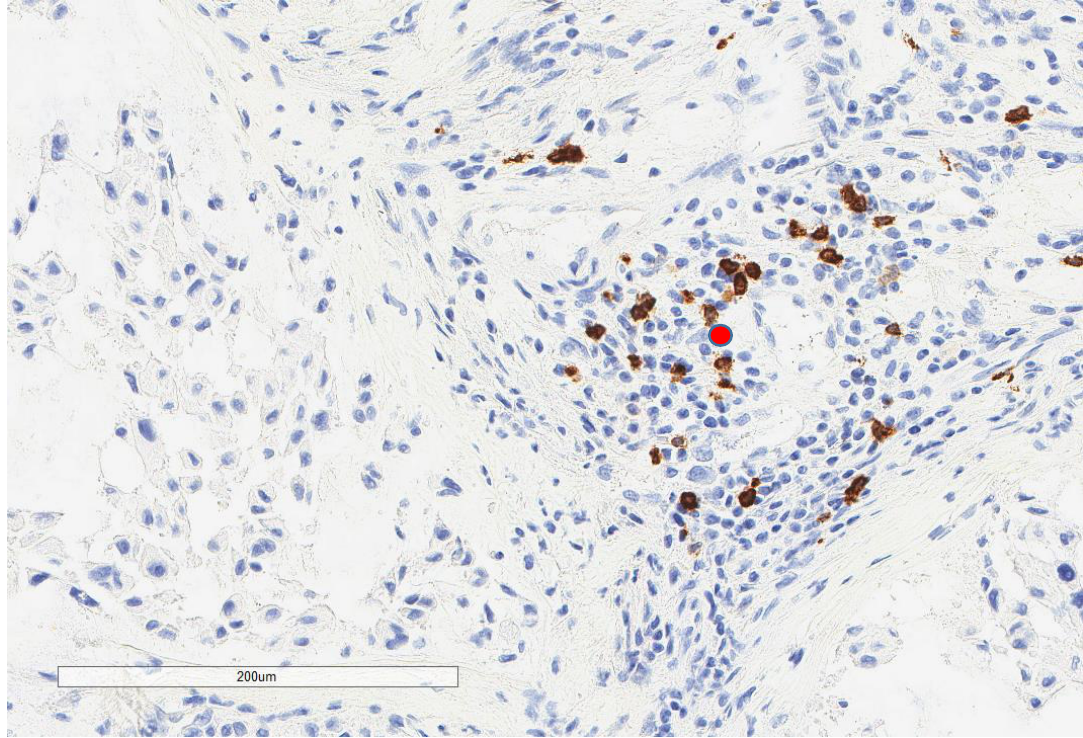
Figure 5. Representative microscopic image (×200 magnification) of low CD8 expression (red circle).